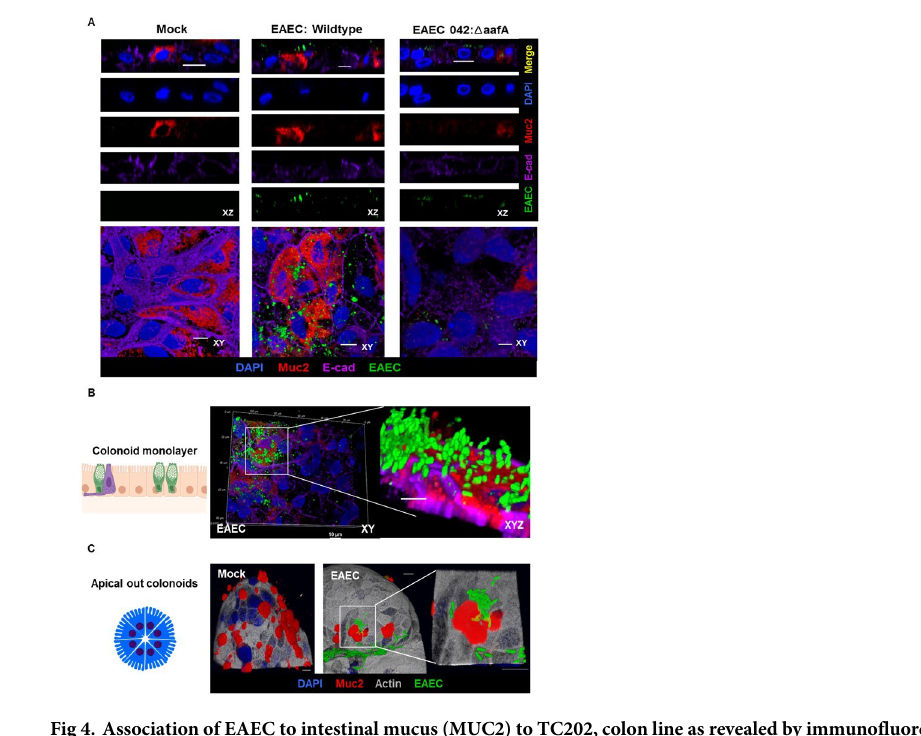
Fig 4. Association of EAEC to intestinal mucus (MUC2) to TC202, colon line as revealed by immunofluorescence micrographs. (A) Representative confocal micrographs of HIEMs stained for nuclei (DAPI, blue), MUC2 (Red), E- cadherin (Purple) and EAEC (GFP, green). HIEMs were either mock treated or infected with EAEC A2A:GFP or EAEC: Δ aafA at a MOI of 10 for three hours. (B) Volume projections of EAEC A2A:GFP infected HIEMs (C) EAEC infection on apical out colonoids. 3D reconstruction images show EAEC growing above goblet cells secreting MUC2. (Inset shows higher magnification). Scale bars indicate 10 μ m.